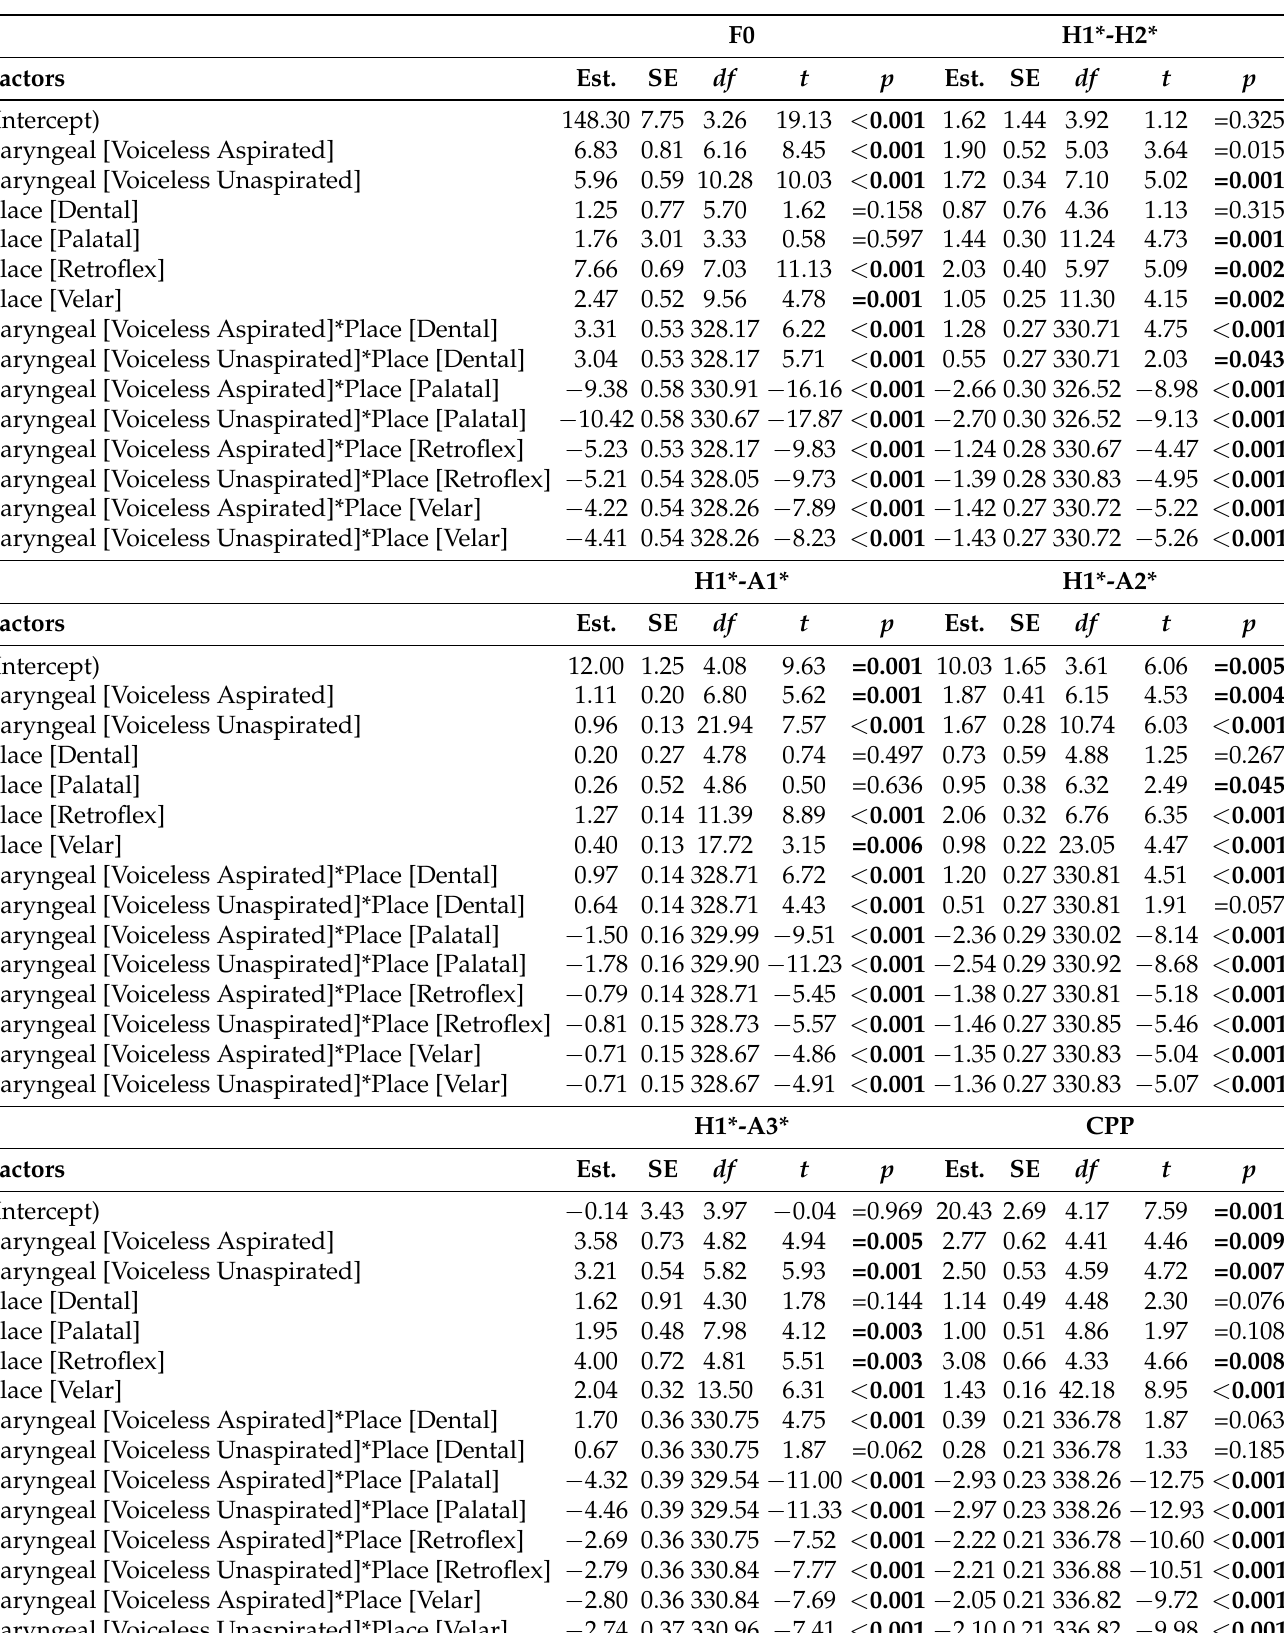
Table 2. Results of LMER models of F0, H1*-H2*, H1*-A1*, H1*-A2*, H1*-A3*, and CPP. Statistically significant results are shown in bold, with an alpha value of p =